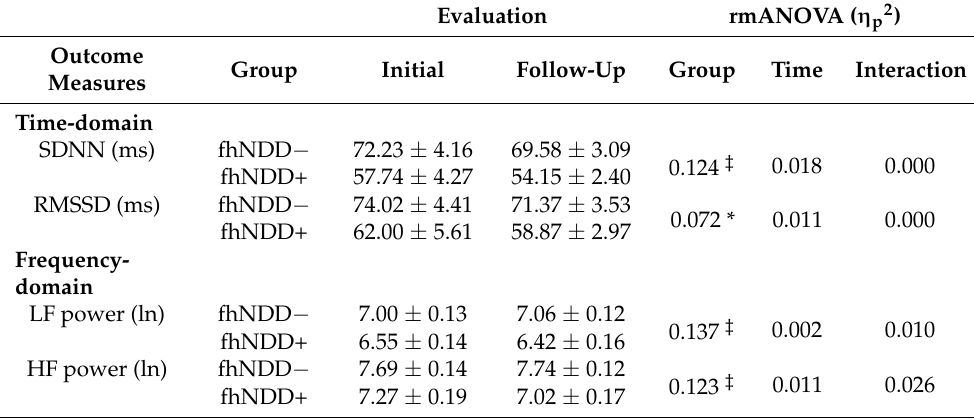
Table 3. Descriptive statistics for heart rate variability (HRV) during the 5-min self-paced breathing assessment at each evaluation. Evaluation rmANOVA ( η p2